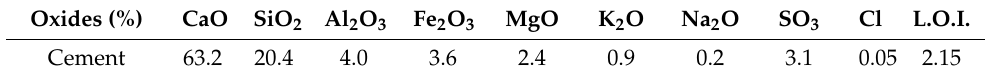
Table 1. Chemical composition of cement (%).